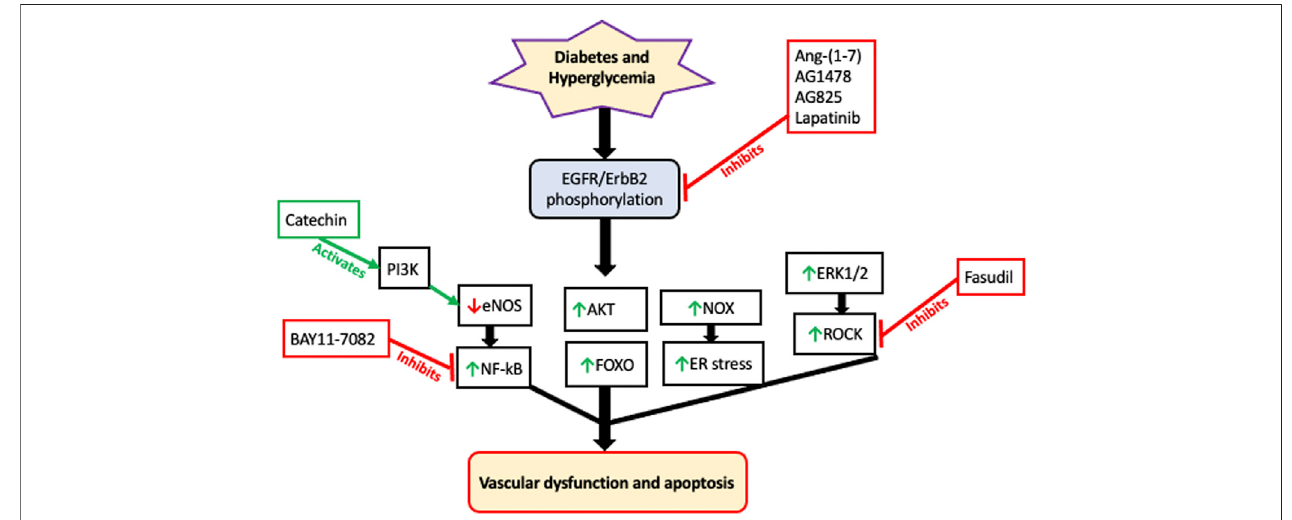
FIGURE 2 | A schematic of the likely signaling effectors of EGFR/ErbB receptors in mediating diabetes-induced vascular dysfunction. Although there is now evidence that all four ErbB receptors may be activated by hyperglycemia, the majority of the data suggests that diabetes induced vascular dysfucntion proceeds via phosphorylationandsubsequenthetero-dimerizationEGFRandErbB2receptors.Thisisturnbeginsacascadeofdownstreamsignalingpathwaysincludingattenuation of eNOS that results in decreased NO production. Activation of P13K, such as by green tea components like catechin, can rescure eNOS and reduction in NO. eNOSappearstobeupstreamofNF-kBactivation.Additionally,ERK1/2activationleadstodownstreamROCKsignaling – akeydriverofpro-contractilechangesleading to vascular dysfunction. Interestingly, activation of AKT and FOXO occur independently of each other implying that uncoupling of AKT-FOXO axis is a key component in developing diabetes-induced vascular complications. There is also evidence that EGFR/ErbB2 signaling via NADPH-oxidase (NOX) leads to increased ROS/oxidative andERstressinthediabeticcardiovascularsystem.Theprecisecross-talkandinterplaybetweentheseandotherpathwaysremainstobefullyelucidated.Furthermore, sincemultiple geneexpression changesareknowntocorrected byEGFRinhibition inthediabeticvasculature, itisvery likelythatthesignaling pathways discussedhere will act in concert with multiple other, as yet uncon fi rmed, signaling cascades that are downstream of EGFR/ErbB receptors to eventually lead to diabetes-induced vascularcellapoptosis anddysfunction.Someofthereportedpharmacologic interventions used intheanalysesofthese pathways arealsoshown;reddead-end arrow indicates inhibition; green arrow indicates activation (refer to the main text for more details and